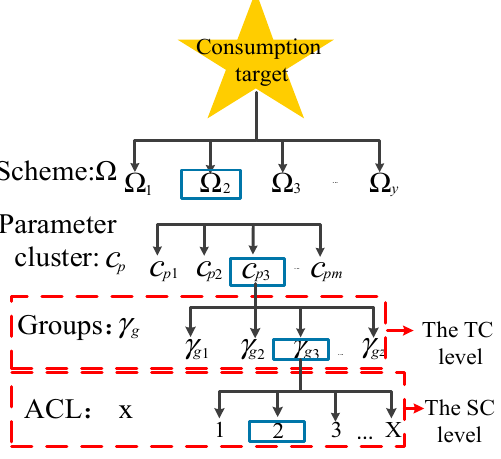
Figure 3. Hierarchical priority setting.